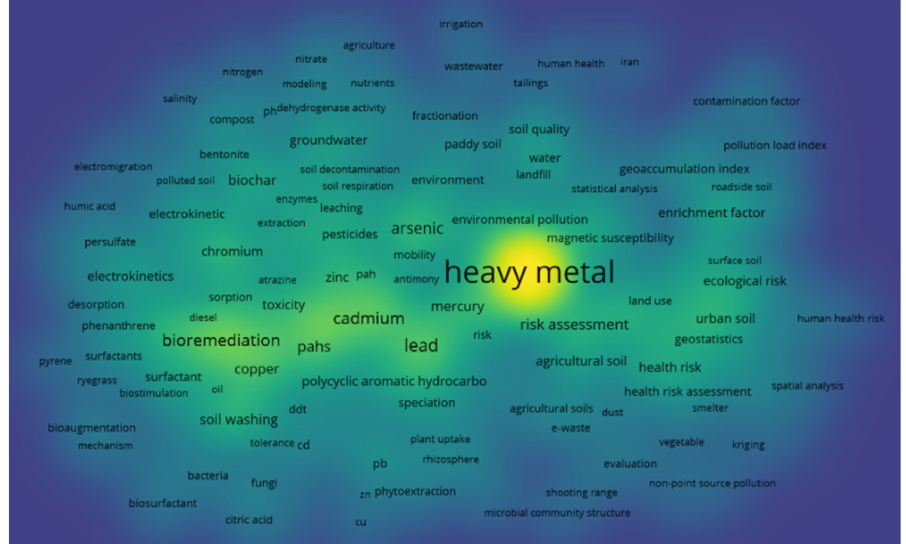
Figure 3. Thermodynamic chart of keyword